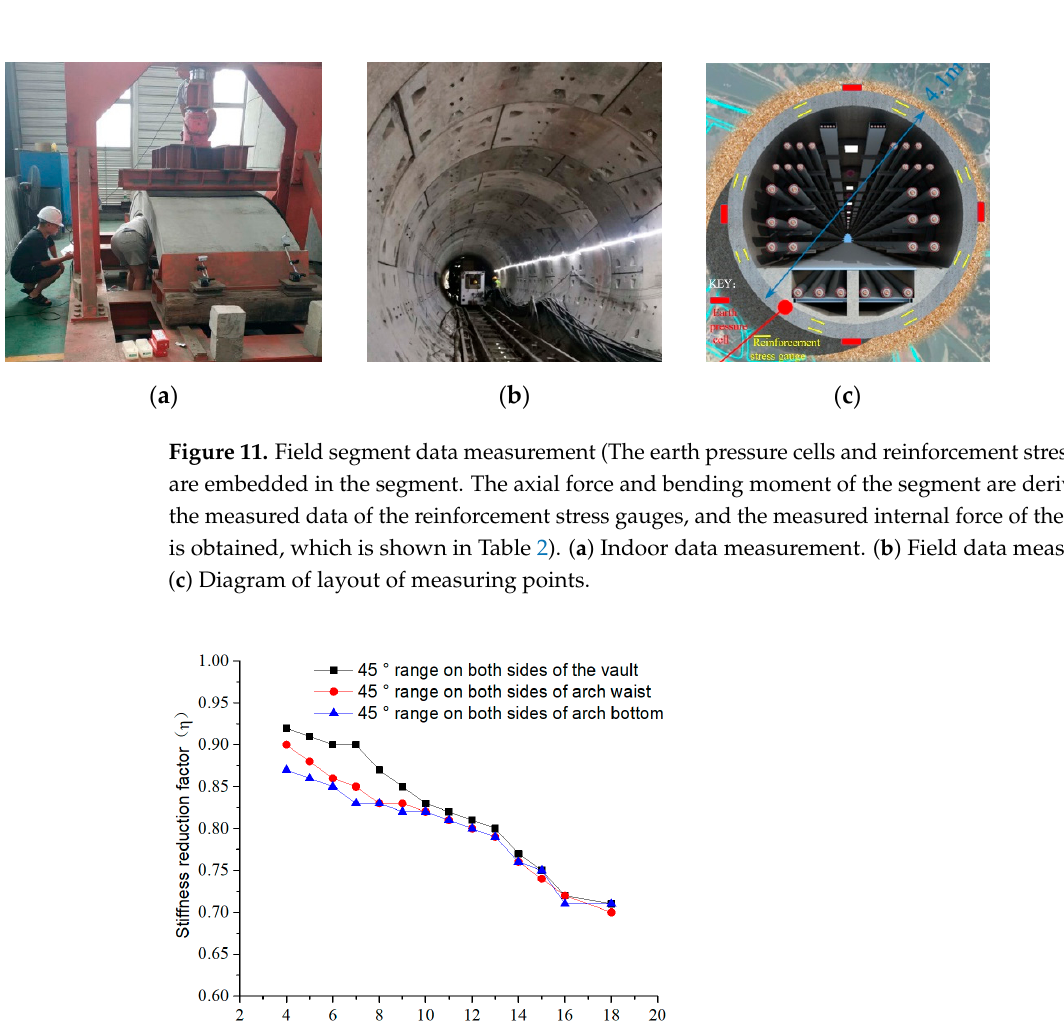
Figure 12. Relationship curve of stiffness reduction factor.